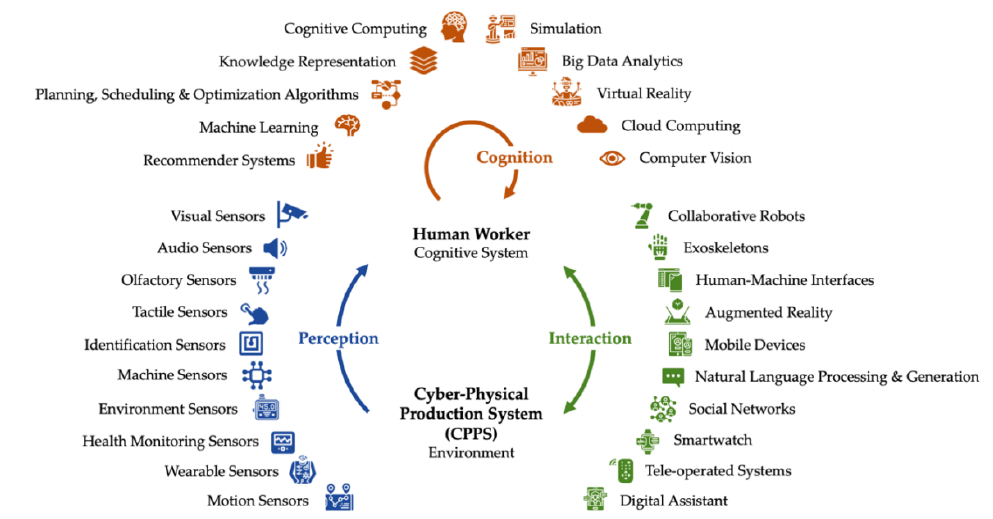
Figure 1. Symbiotic human-machine relationship in the Industry 5.0